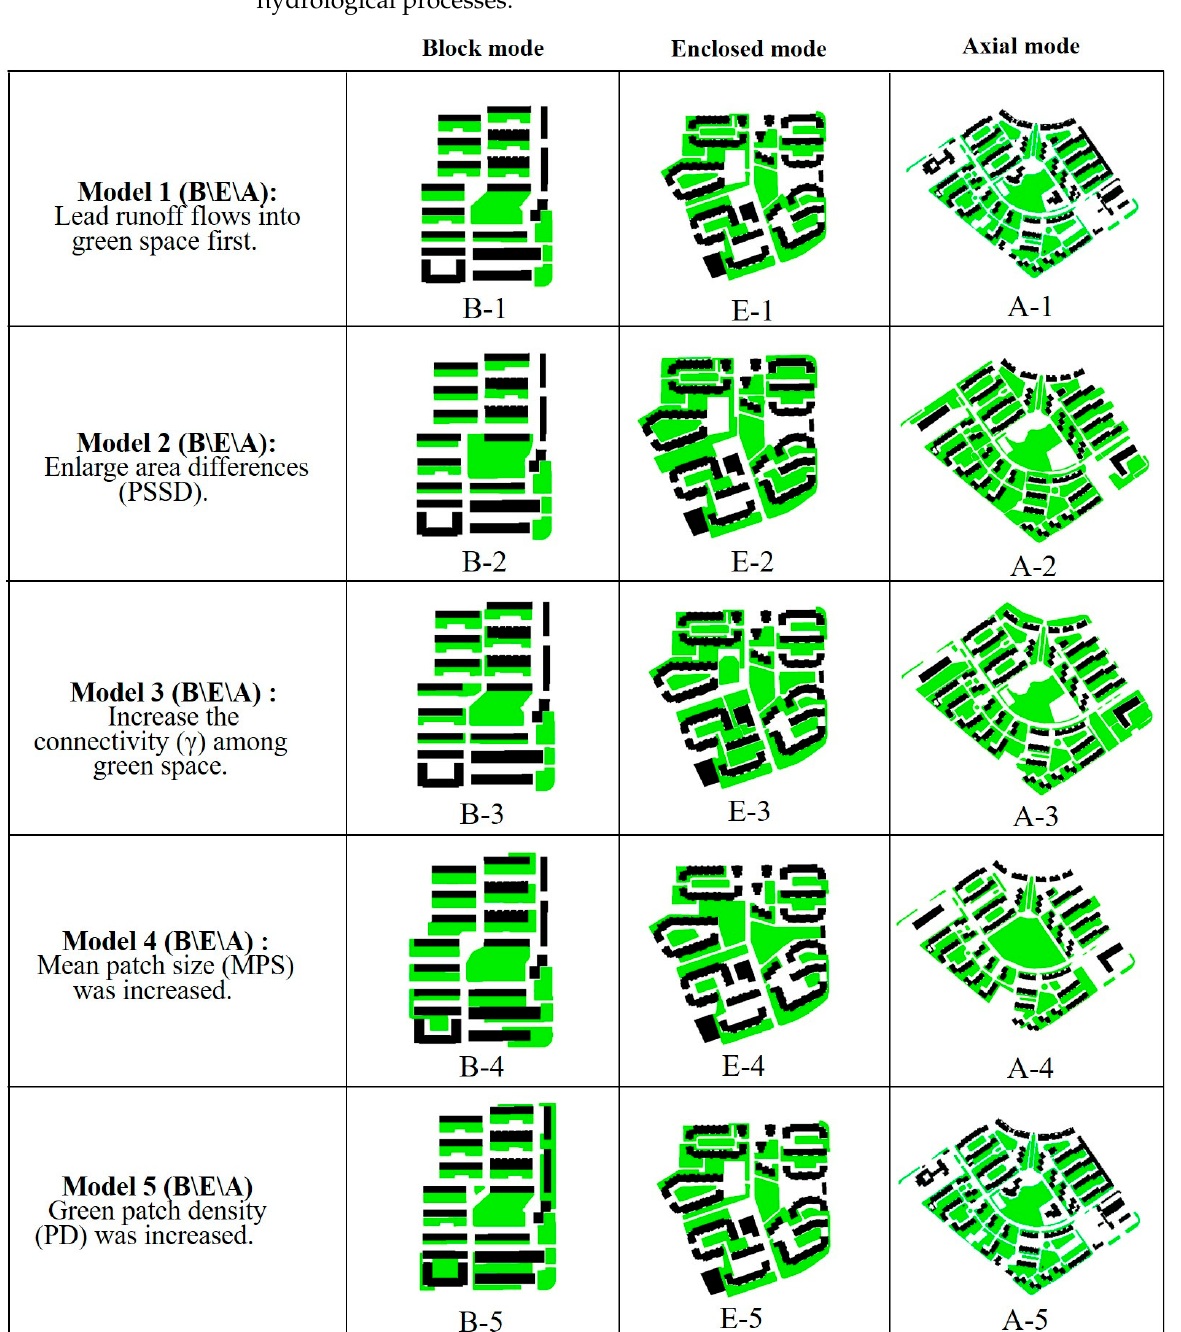
Figure 6. UGS layout design of 15 “what-if” scenarios in block mode, enclosed mode, and axial mode in URAs.